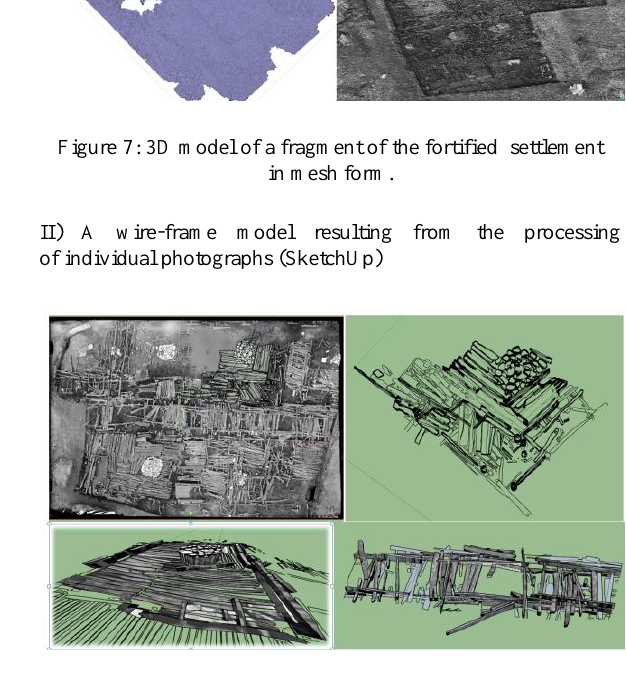
Figure 8: A wire-frame model of: A-C) a fragment of the main room of a residential farm building, D) main road developed using SketchUp